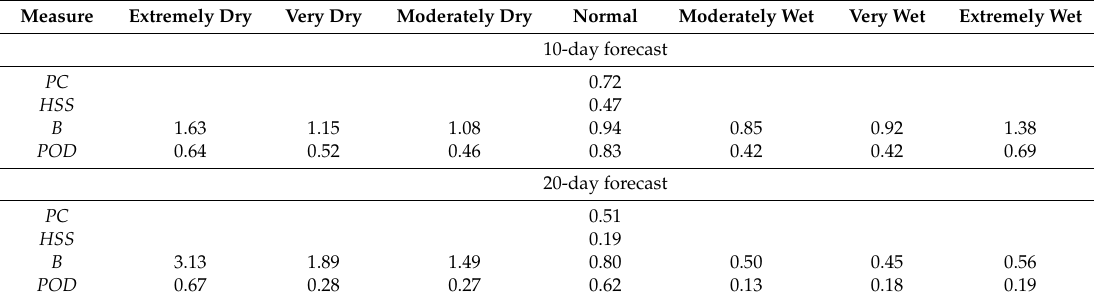
Table 5. Measures of accuracy for SPI forecasts in seven